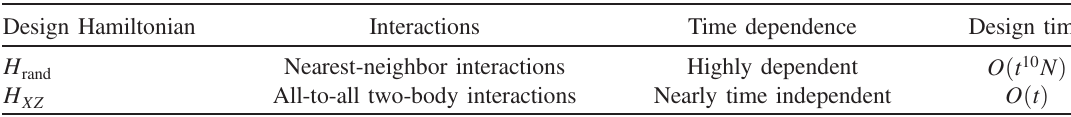
TABLE II. A comparison of design Hamiltonians, H natural design Hamiltonian conjecture. The design time of H and N . Although the improvement in terms of t is generic to H interactions (see the main